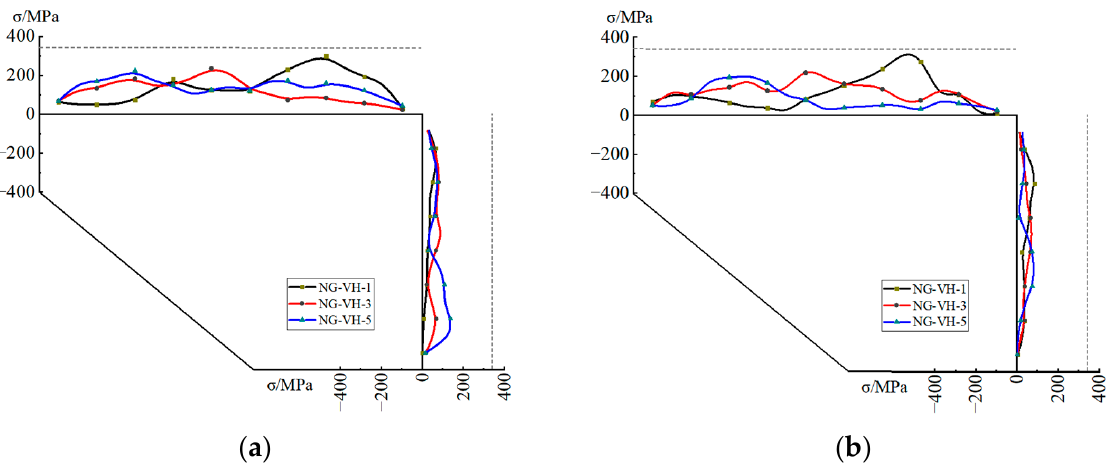
Figure 16. The Von Mises stress distributions on the gusset interfaces at 2% drift: ( a ) Joint closing; ( b ) Joint opening.